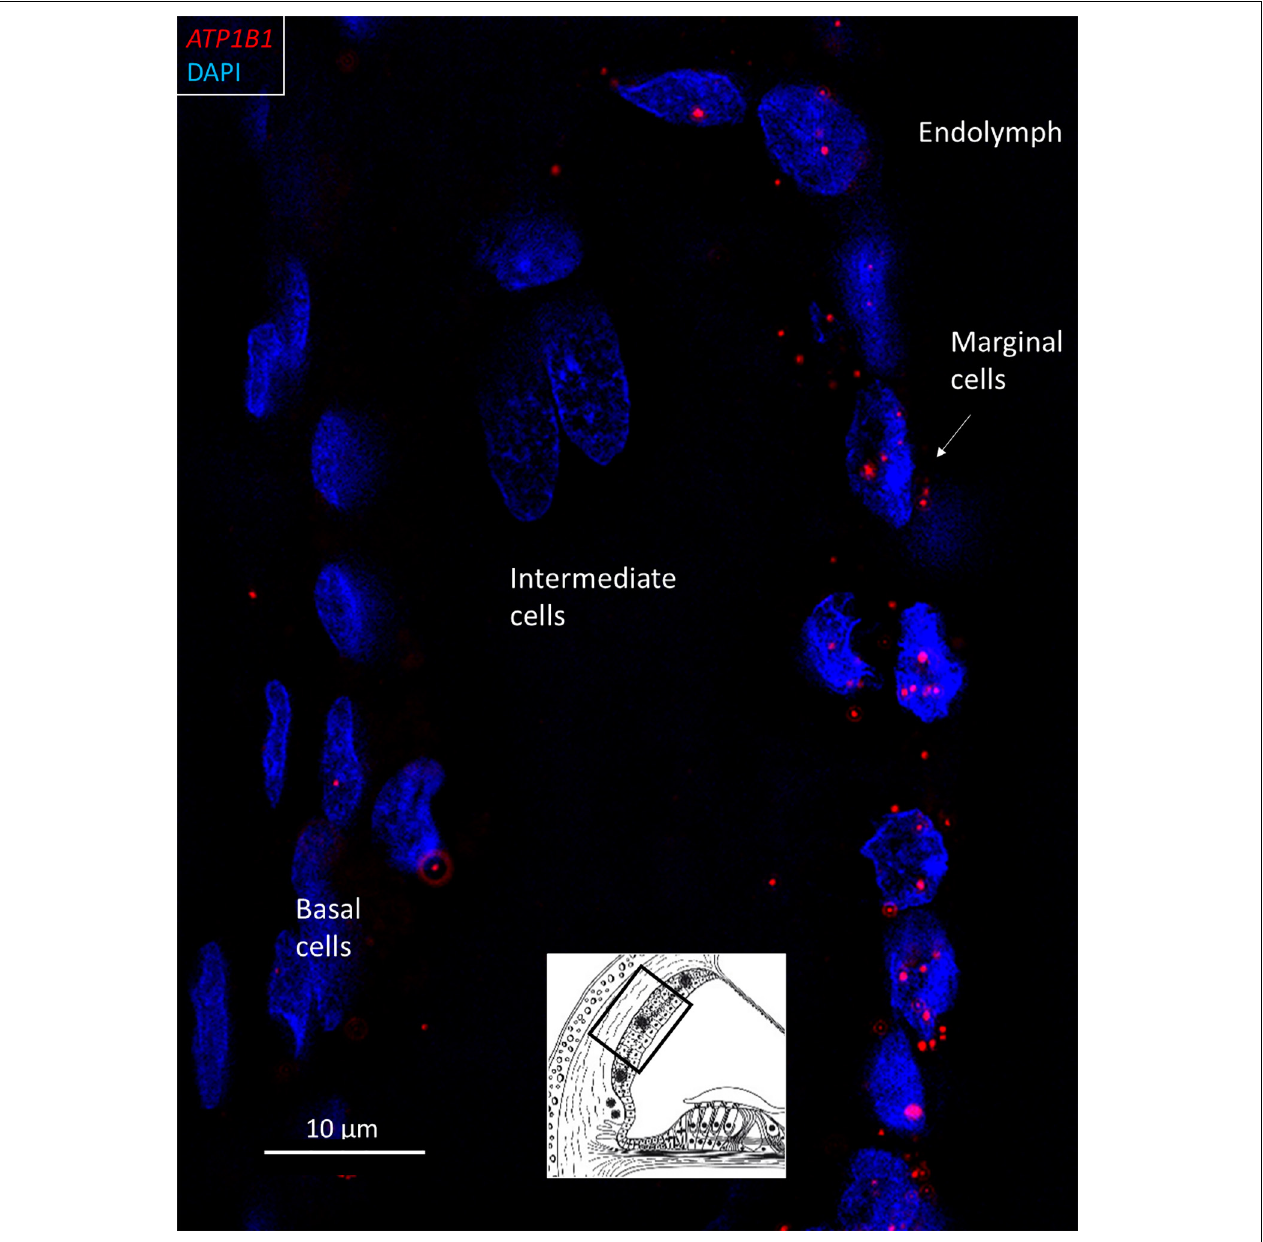
FIGURE 4 | SR-SIM of ATP1B1 gene transcripts (red spots) expressed in the marginal cells of the SV in the basal turn of the human cochlea (inset). Gene expression is restricted to the cells contacting endolymph, with only a few transcripts present in the intermediate and basal